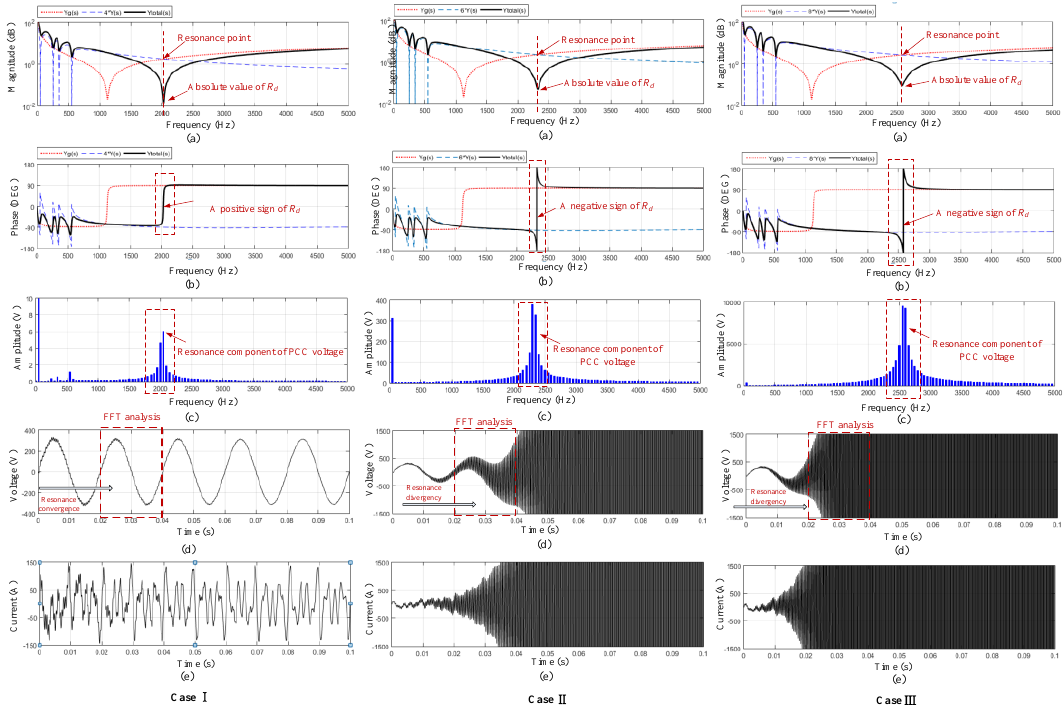
Figure 11. Frequency analysis and simulation results of four (case I), six (case II), and eight (case III) parallel VSI systems. ( a ) Amplitude–frequency plot; ( b ) phase–frequency plot; ( c ) FFT analysis of the parallel VSI systems. ( a ) Amplitude – frequency plot; ( b ) phase – frequency plot; ( c ) FFT analysis of the PCC voltage; ( d ) PCC voltage; ( e ) total output PCC voltage; ( d ) PCC voltage; ( e ) total output current.